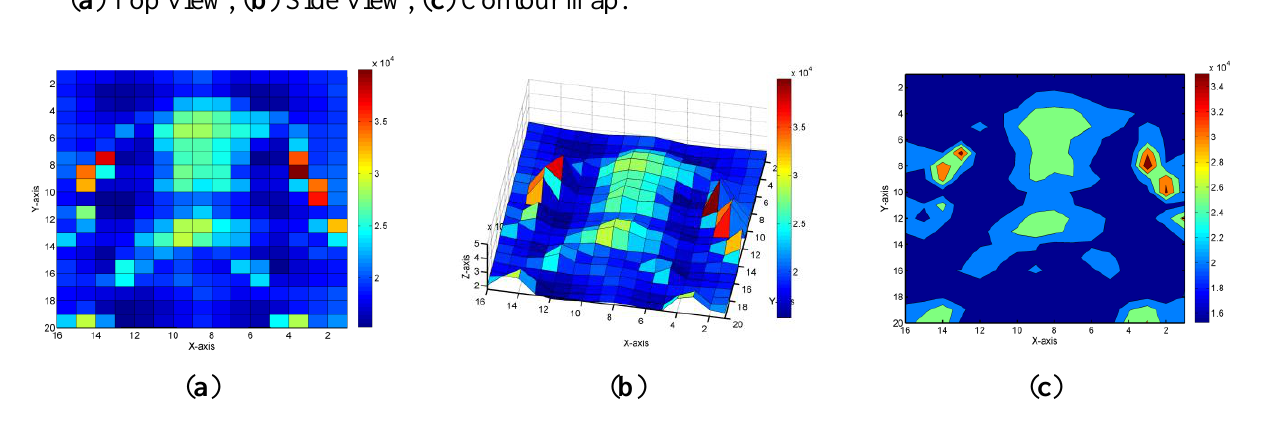
Figure 10. The sensory map of a participant lying on the FPCSM in a supine position.